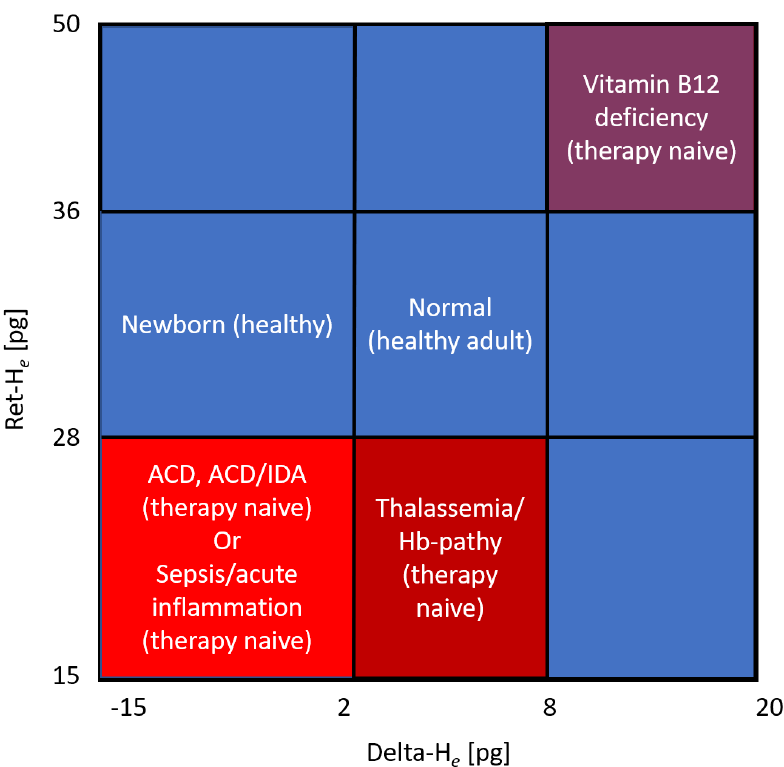
Figure 2. Hema-plot (adapted from Weimann et al. [56]) Characterization of anemia based on reticulocyte hemoglobin (RET-H e ) and the difference between it and the hemoglobinization of mature erythrocytes (Delta-H e ).